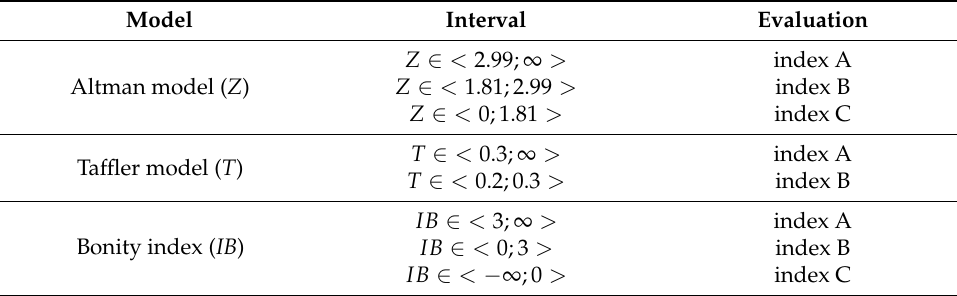
Table 1. Evaluation intervals of the prediction